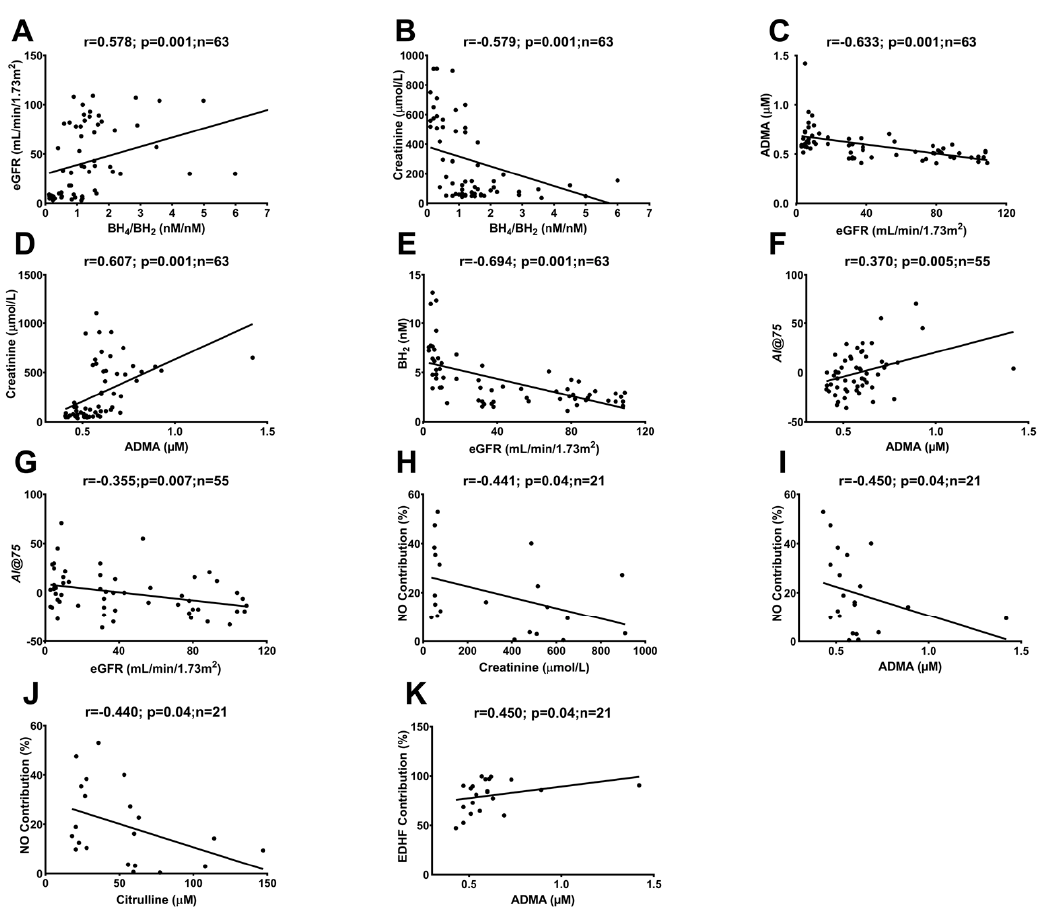
Figure 5. Correlations between the BH 4 /BH 2 ratio with eGFR (r = 0.578; p = 0.001; n = 63) ( A ) and creatinine (r = − 0.579; p = 0.001; n = 63) ( B ), ADMA with eGFR (r = − 0.633; p = 0.001; n = 63) ( C ) and creatinine (r = 0.607; p = 0.001; n = 63) ( D ), BH 2 with eGFR (r = − 0.694; p = 0.001; n = 63) ( E ), AI@75 with ADMA (r = 0.370; p = 0.005; n = 55) ( F ) and eGFR (r = − 0.355; p = 0.007; n = 55) ( G ), NO contri- bution with creatinine (r = − 0.441; p = 0.04; n = 21) ( H ), ADMA (r = − 0.450; p = 0.04; n = 21) ( I ) and citrulline (r = − 0.440; p = 0.04; n = 21) ( J ), ADMA with EDHF contribution (r = 0.450; p = 0.04; n = 21) ( K ) in all participants. Spearman’s rank correlations were performed for the analysis. ADMA, cit- rulline and BH 4 /BH 2 were measured using chromatographic separation; AI@75 was measured in vivo using EndoPAT and NO; EDHF contribution was measured ex vivo using the wire myograph technique. ADMA = asymmetric dimethylarginine; BH 4 = tetrahydrobiopterin; BH 2 = dihydrobiop- terin; NO = nitric oxide; EDHF = endothelium-derived hyperpolarizing factor. The contribution of the percentage of NO and EDHF was calculated using pharma- cological tools (Figure S2). As NOS and COX inhibition entirely blocks NO and PGI2, if any, the remaining response is considered EDHF-mediated dilatation. We have observed that the inhibition of only COX does not change the dilation (Figure S3), suggesting that the PgI2 response is absent in those resistance arteries, and we have considered that only NO and EDHF are present in those arteries. In CKD-5 patients, endothelium-mediated dilatation was positively correlated with phenylalanine (Figure 6A), and BH 4 was nega- tively correlated with ADMA and ornithine, respectively (Figure 6B,C).